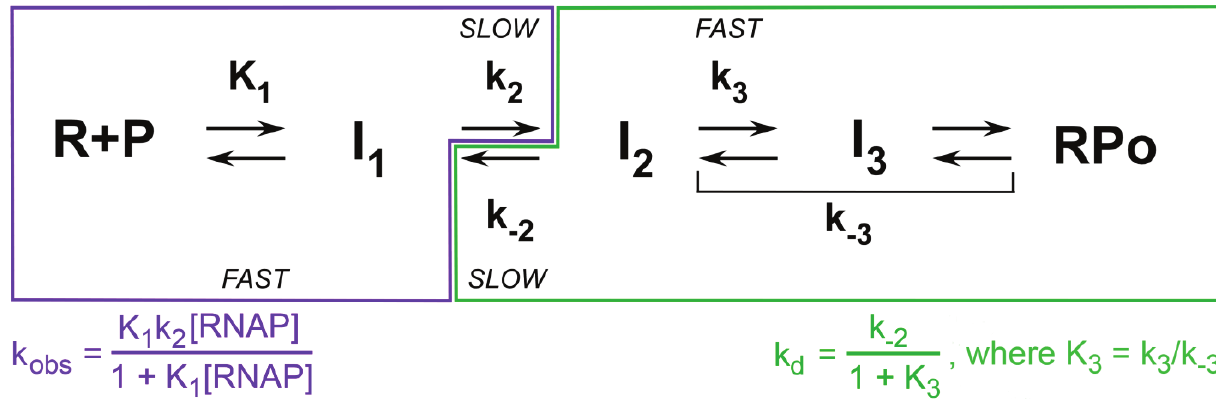
Figure 4. Mechanism of transcription initiation: resolvable kinetic steps. Minimal mechanisms of open complex formation and dissociation, showing by color coding the steps that contribute to the observed rate constants (k obs , k d ) for promoters like (cid:7)P R that form a stable open complex RP O . For the common experimental situation of excess RNAP, the rate constant for open complex formation (k obs ) is determined by the front half of the mechanism (boxed in purple), including the equilibrium constant K 1 for formation of the ensemble of closed (I 1 ) intermediates, the forward rate constant k 2 of the isomerization step that includes DNA opening, and the excess RNAP concentration. Likewise, k d is determined by the late steps of the mechanism (boxed in green), including the rate constant k -2 for DNA closing and the equilibrium constant K 3 for stabilization of the initial open complex I 2 to form longer-lived I 3 and/or RP O complexes